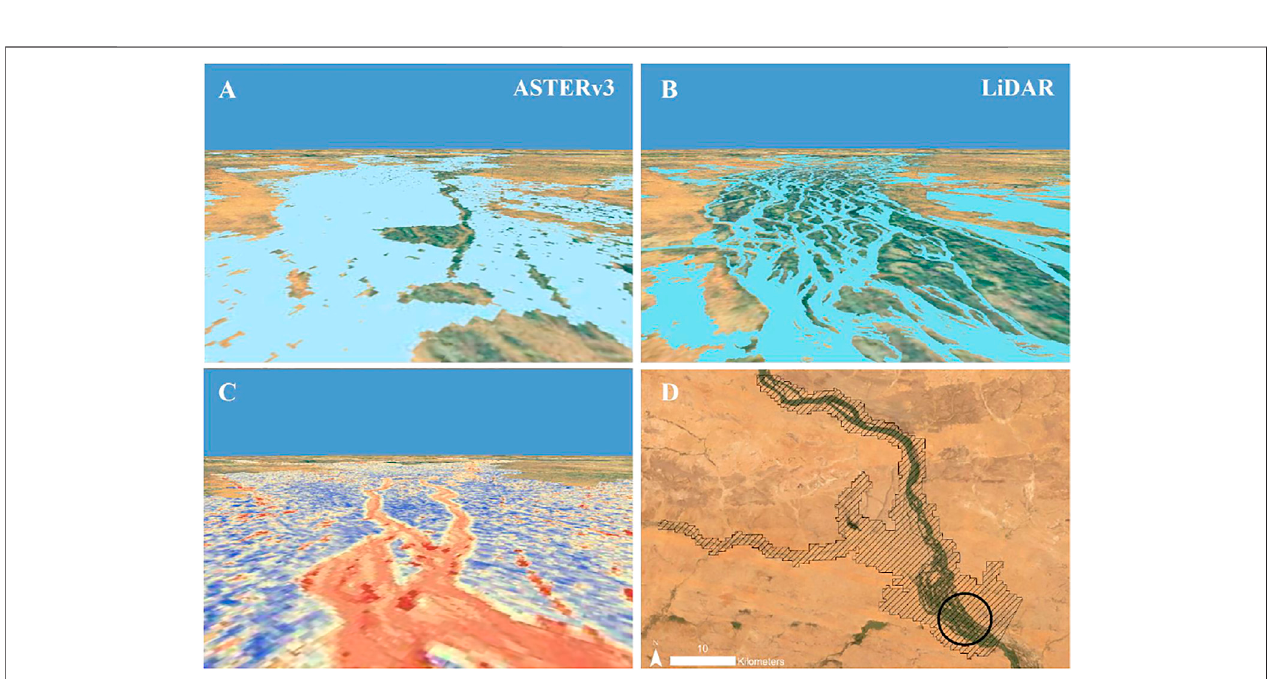
FIGURE 6 | ASTER and LiDAR DEM extents at 2 m fl ood height in (A,B), respectively. (C) ASTER and LiDAR distribution of elevation differences where red overestimates elevation and blue underestimates elevation (D) location indicator within the study area of A, B and C.